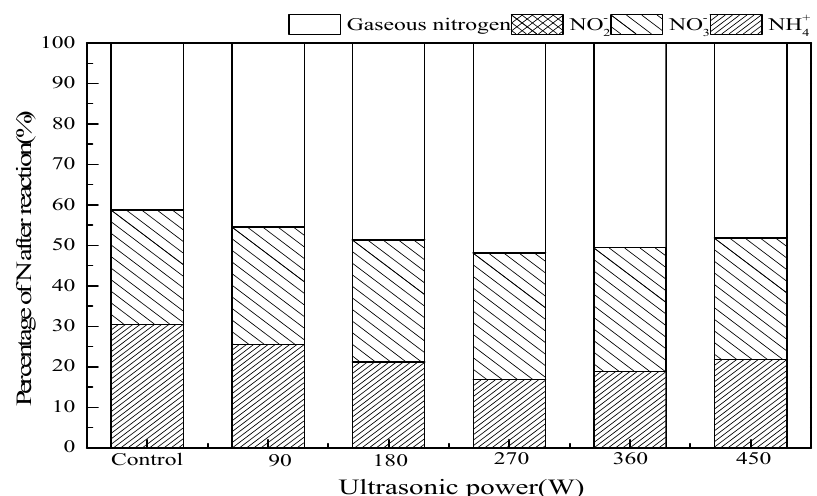
Figure 7. The effect of ultrasonic power on ammonia conversion. Reaction conditions: initial NH 4+ concentration 50 mg/L, initial pH 9.5, ozone flow 0.8 g/h, catalytic dosage 2.0 g/L, temperature 25 °C, reaction time 60 min, ultrasonic frequency 25 kHz, ultrasonic power from 0 to 450 W, ultrasonic operation 1 s and interval 2 s.